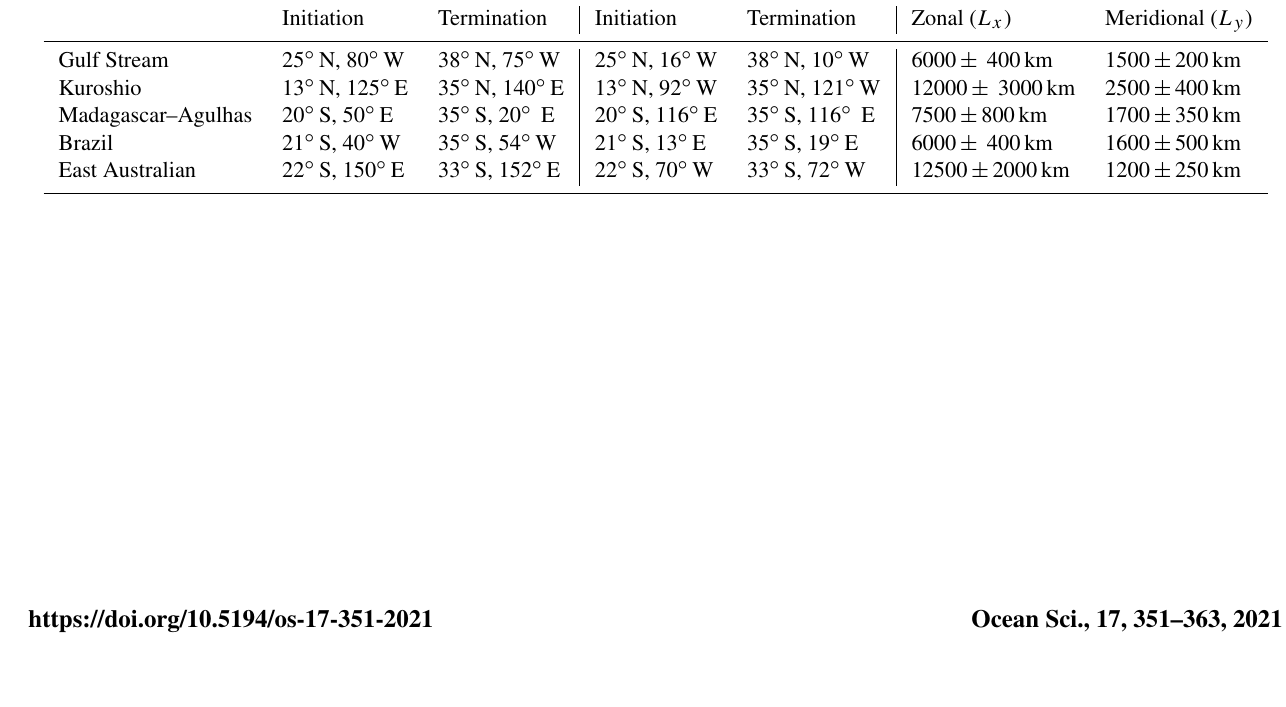
Table C1. Dimensions of the gyres that contain the five western boundary currents in the present-day world ocean. Current Western edge of the basin Eastern edge of the